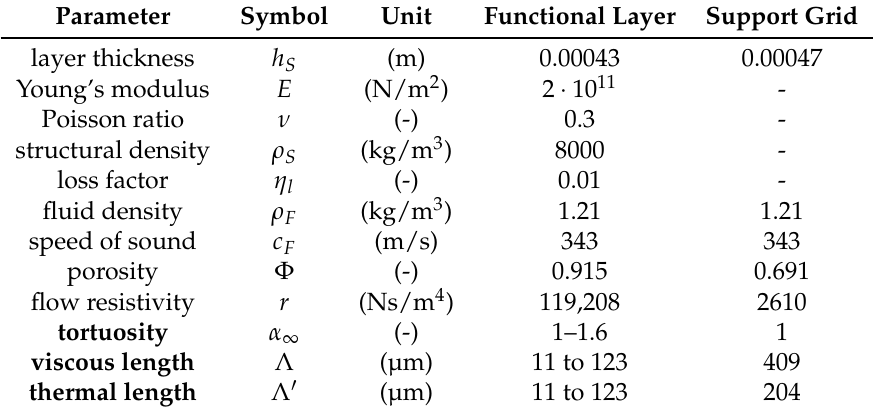
Table 4. Material parameters used for the acoustic